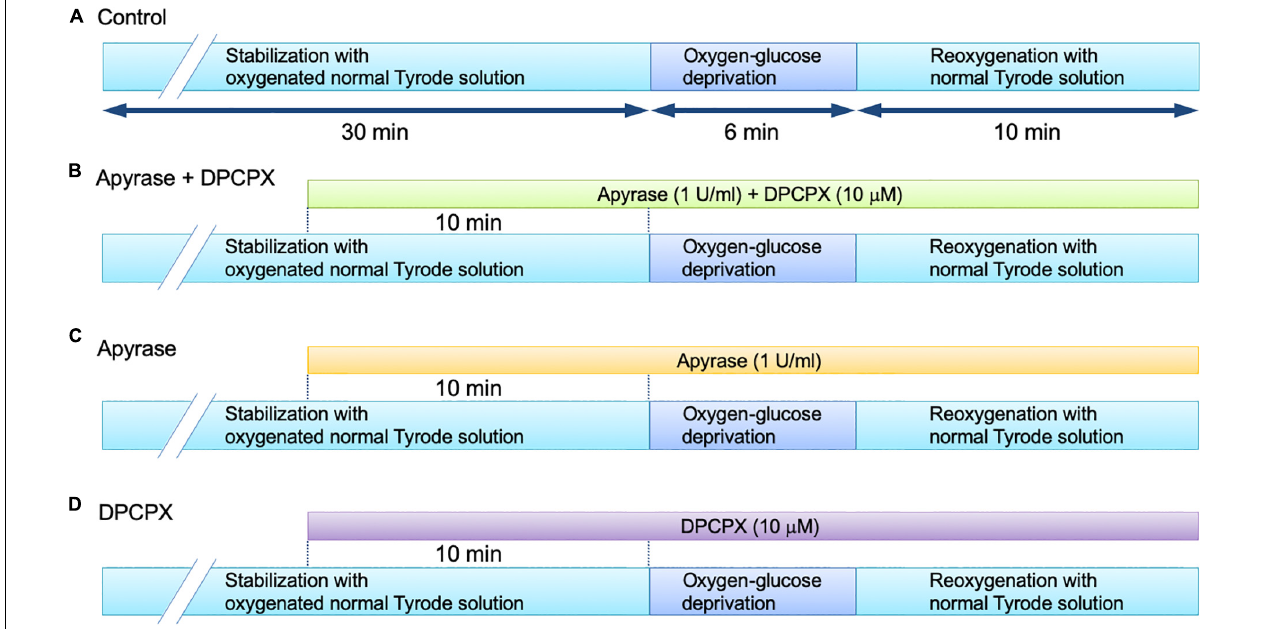
FIGURE 1 | Langendorff-perfusion protocol for isolated mouse hearts in the absence (A) and presence of apyrase + DPCPX (B) , apyrase alone (C) and DPCPX alone (D)